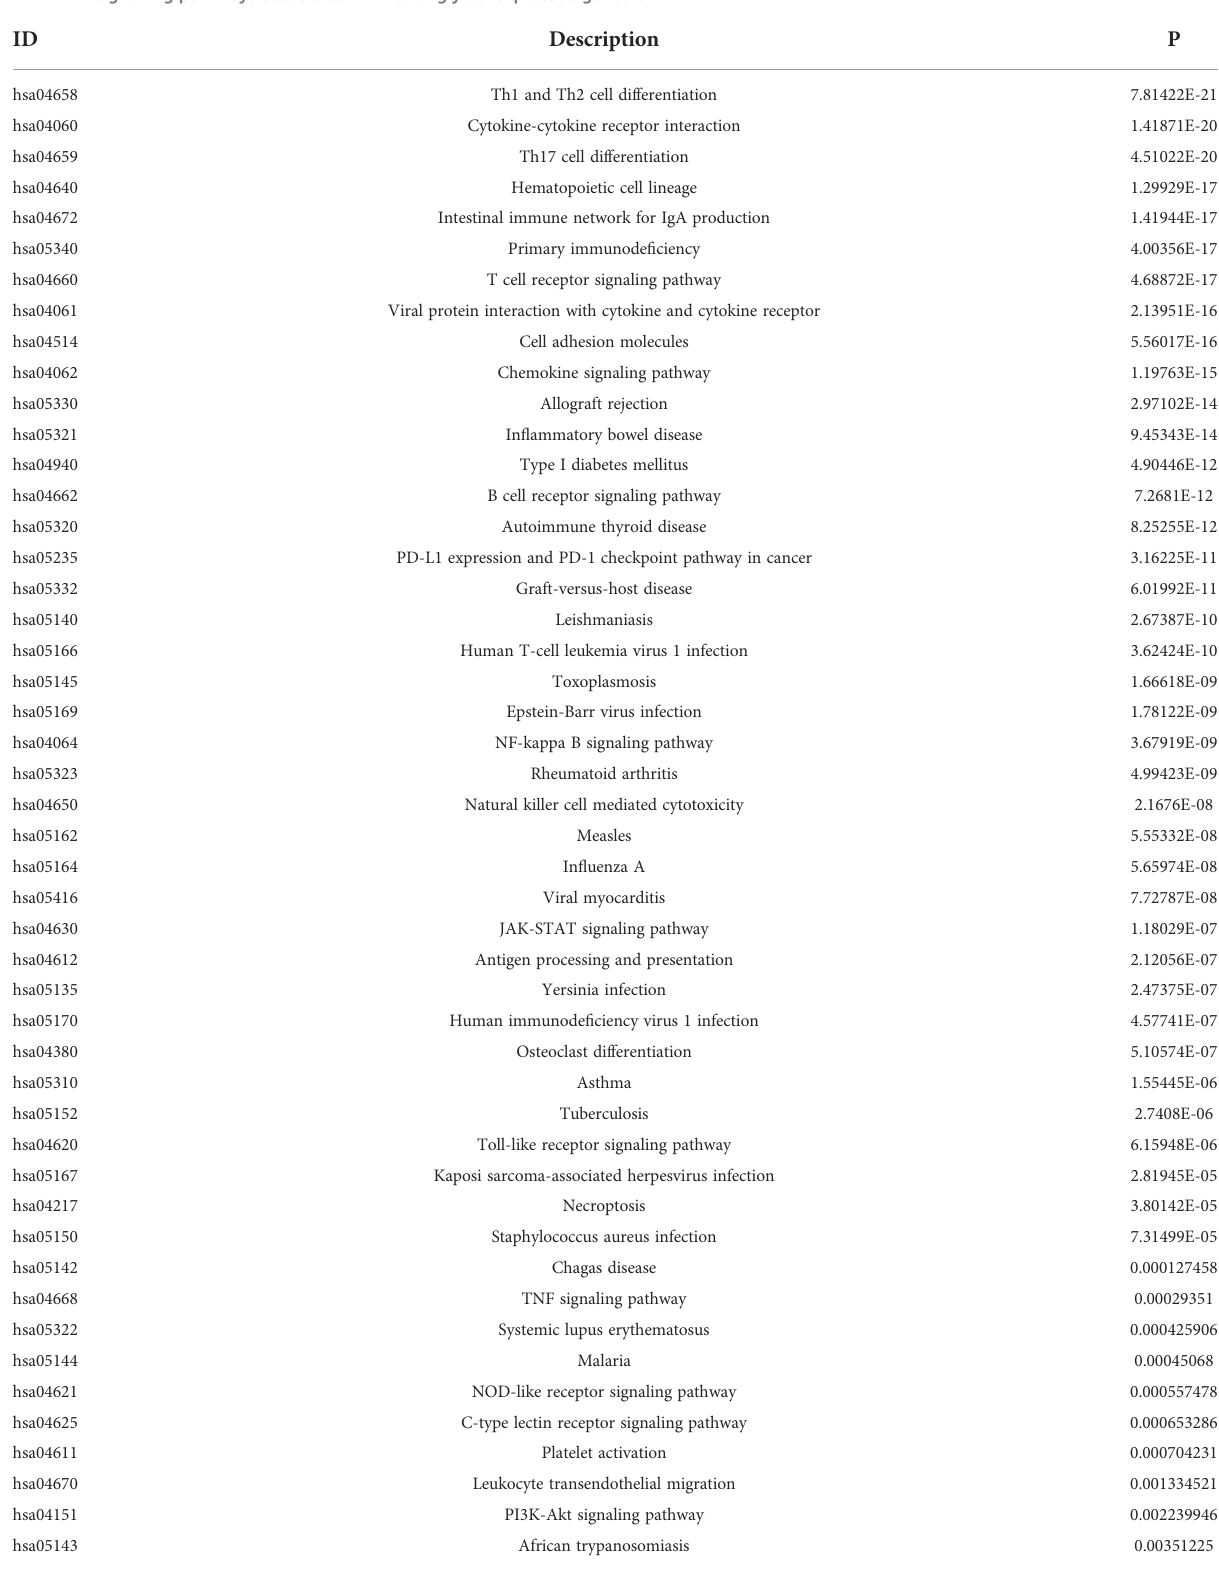
TABLE 2 Signalling pathways associated with strongly co-expressed genes of